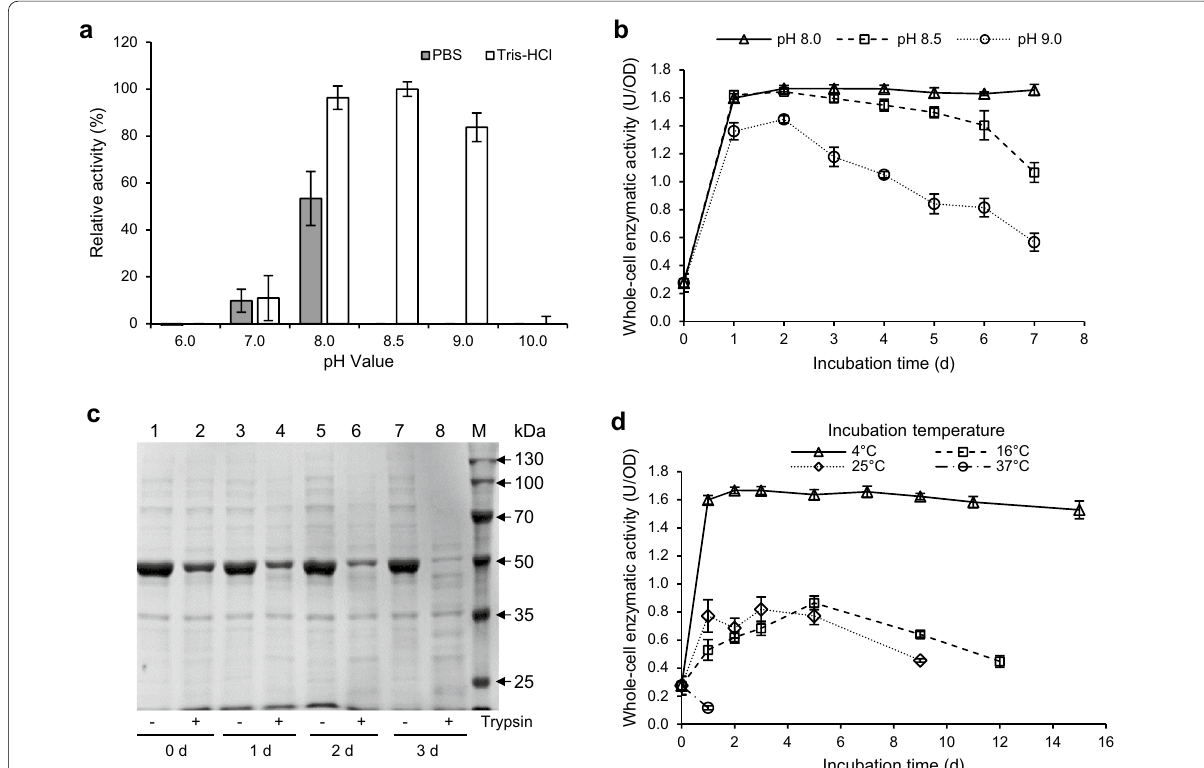
Fig. 3 Effects of pH and temperature on surface-displayed InaPbN-CESH[L] enzymatic activity and stability. a Relative enzymatic activities in buffers with different pH values. The activities were measured after incubation at 4 °C for 5 h. The highest whole-cell enzymatic activity in Tris–HCl buffer (pH8.5) was set to 100%. b The long-term stability at 4 °C in Tris–HCl buffers with different pH values. c Trypsin accessibility assays of the InaPbN-CESH[L] displayed whole cells after incubation at 4 °C. Lanes 1–8, each pair of lanes are trypsin-untreated and treated whole cells with different lengths of incubation time. Lane M, standard protein molecular weight markers. d The long-term stability of the InaPbN-CESH[L] displayed whole cells incubated at different